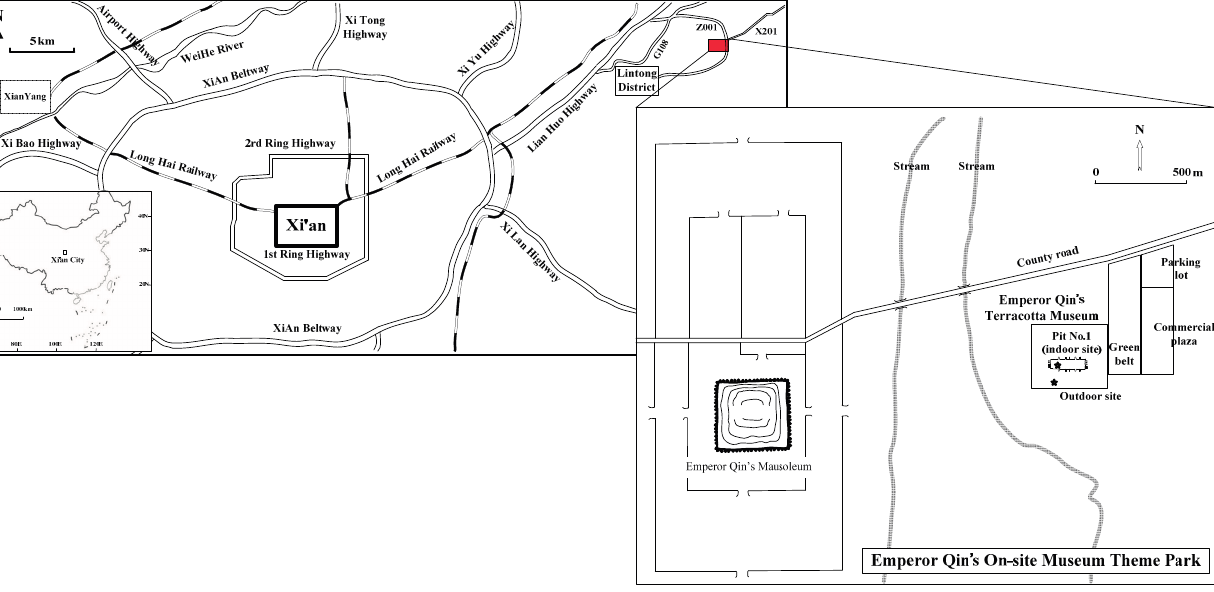
Figure 1. Locations of the sampling sites inside and outside the Pit No. 1 Display Hall of Emperor Qin’s Terra-cotta Museum in Xi’an,